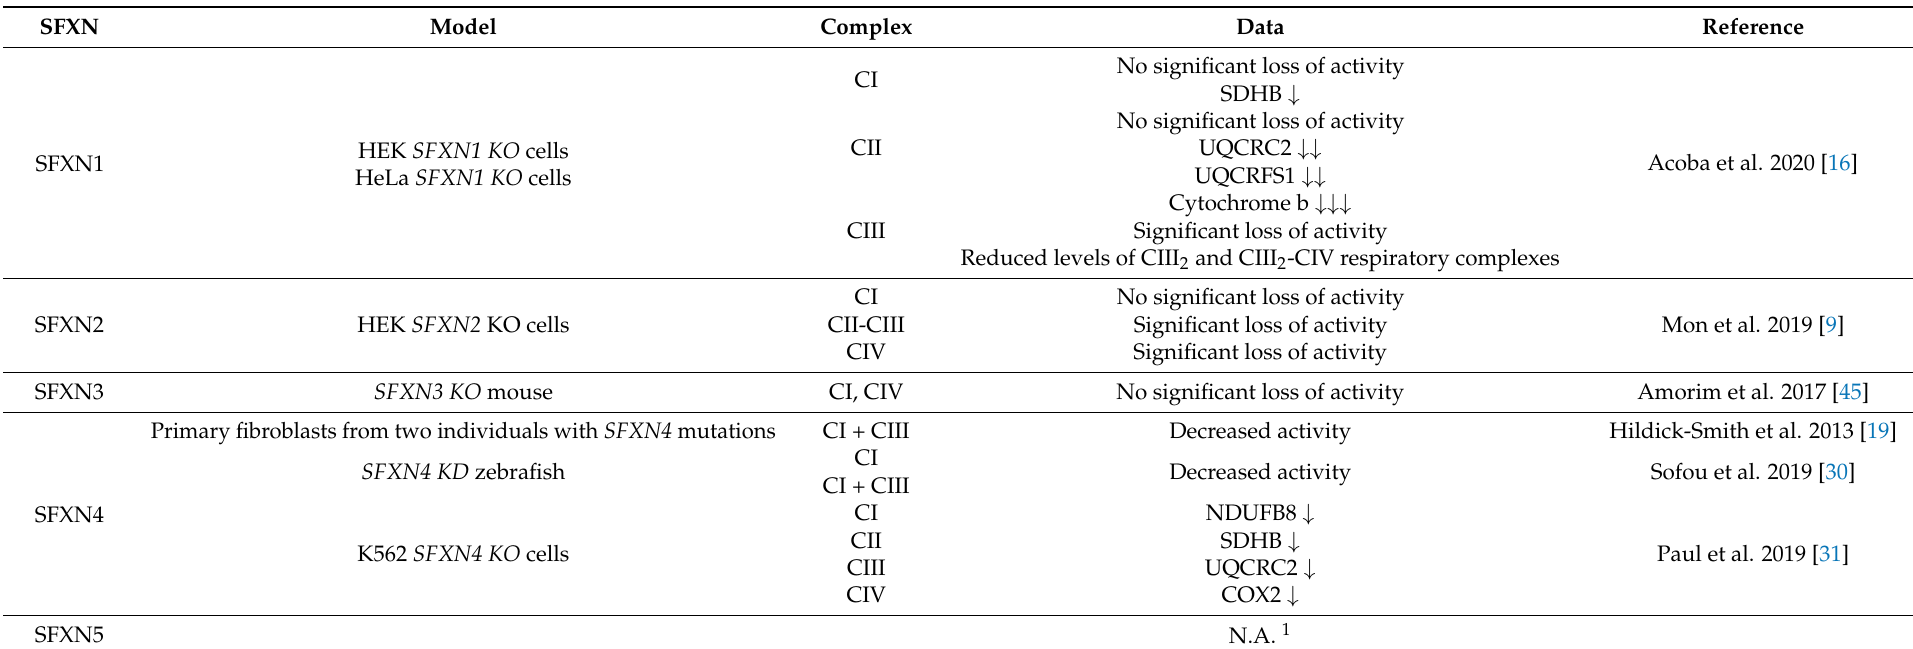
Table 2. Consequences of sideroflexins (SFXN) deficiency on the electron transport chain (ETC)